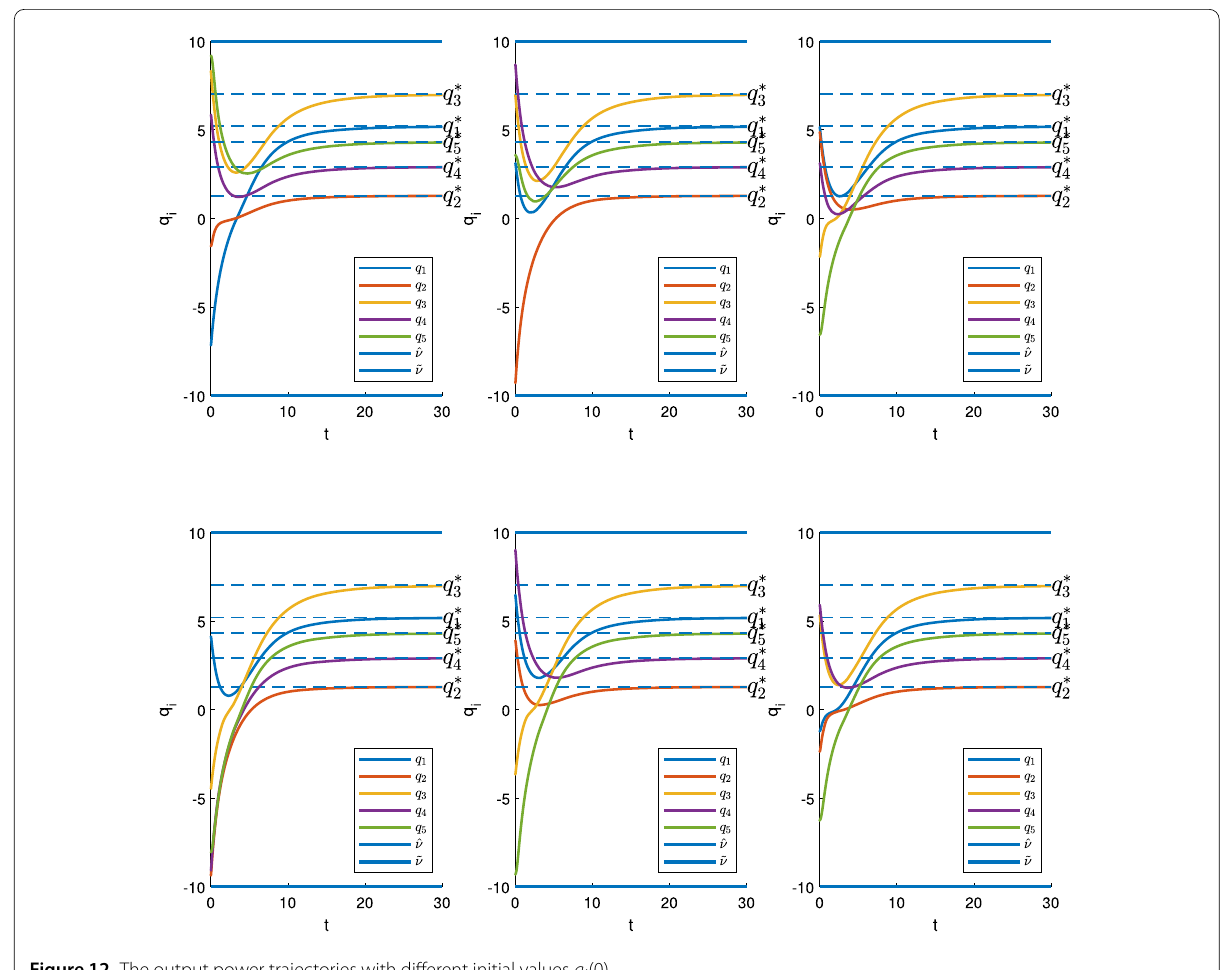
Figure 12 The output power trajectories with different initial values q i